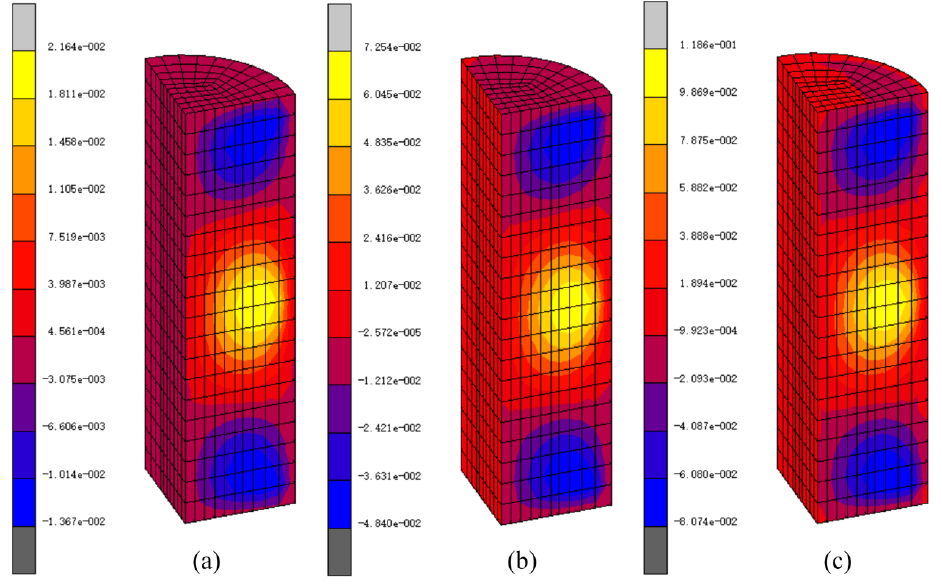
Figure 22. Radial displacement distributions in powder compact at different μ values at ( a ) 0.05, ( b ) 0.2, and ( c ) 0.4.